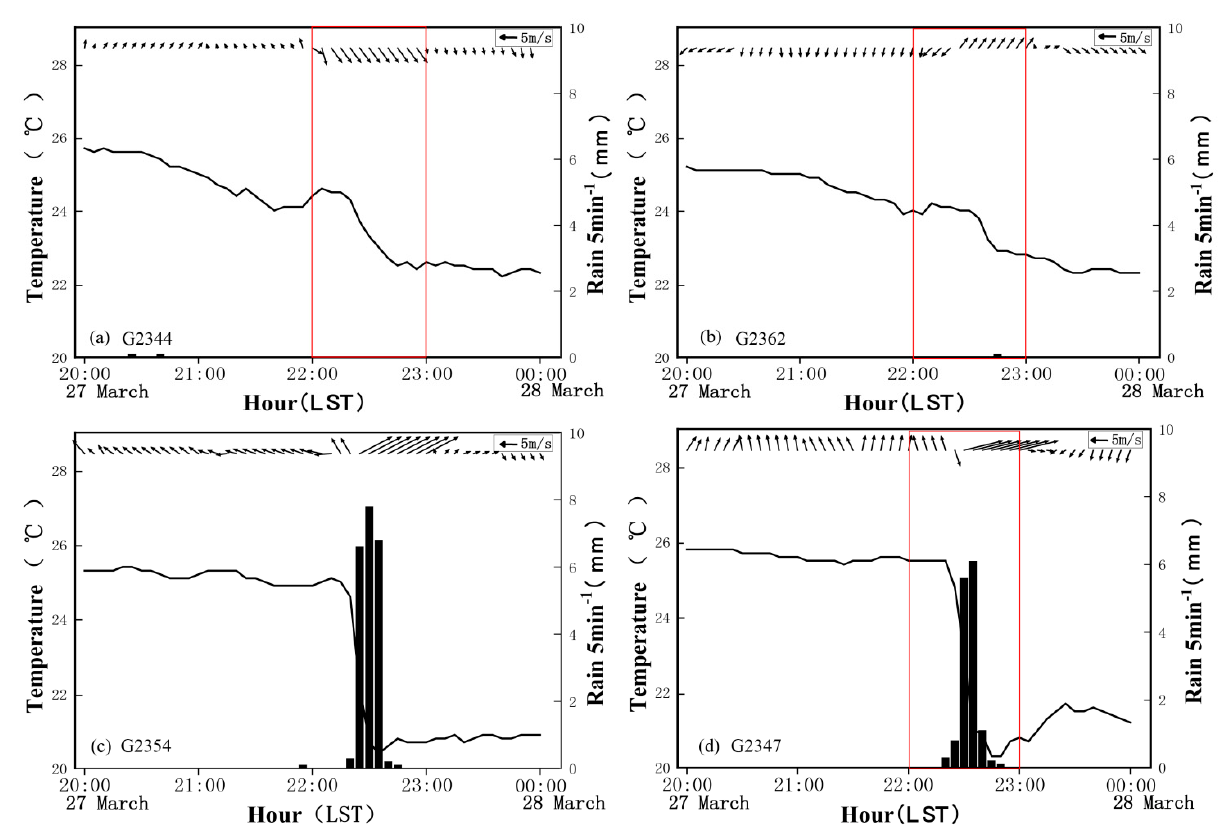
Figure 4. Time series of observed and analyzed wind, temperature, and rainfall at AWSs. ( a ) G2344, Guigang station; ( b ) G2362, Naliu station; ( c ) G2354, Beimian station; ( d ) G2347, Heshui station. The bar graph represents 5–minute rainfall, the solid black line represents the temperature, and the arrow represents the wind.